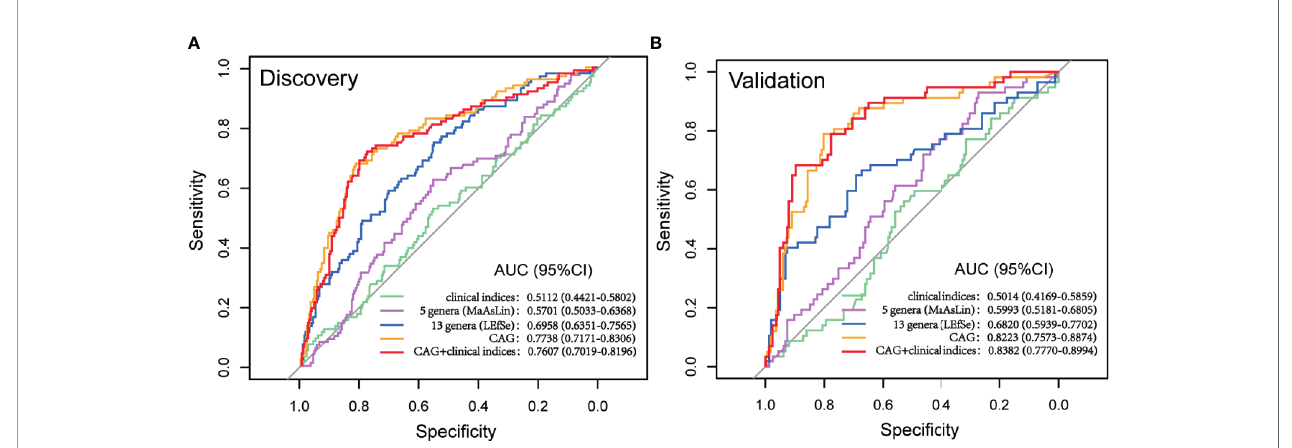
FIGURE 6 | Prediction model of GA based on microbial signatures. (A) Discovery set (GA: 91; control: 244). (B) Validation set (GA: 65, control: 158). GA, gestational anemia; AUC, area under